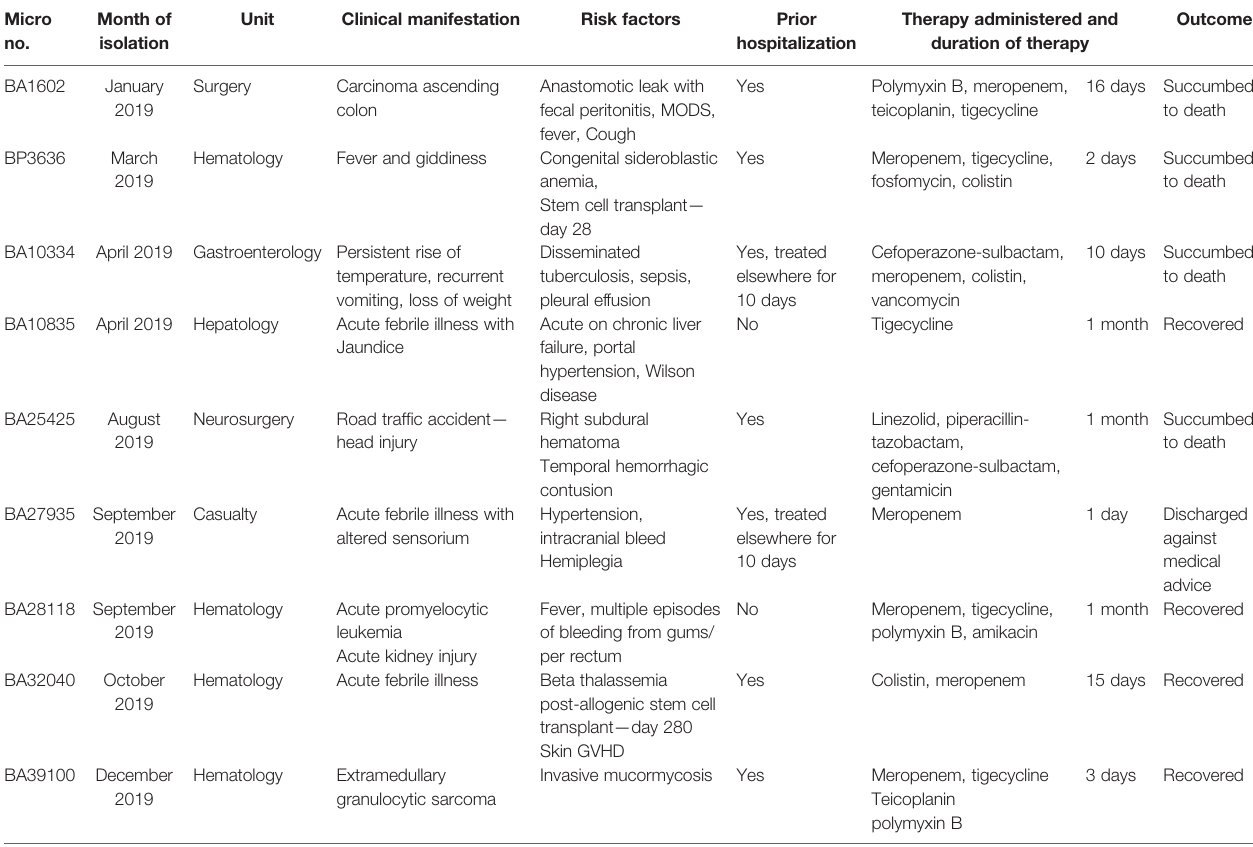
TABLE 1 | The demographic and clinical details of the patients with bacteremia caused by hypervirulent K. pneumoniae ST2096. Micro